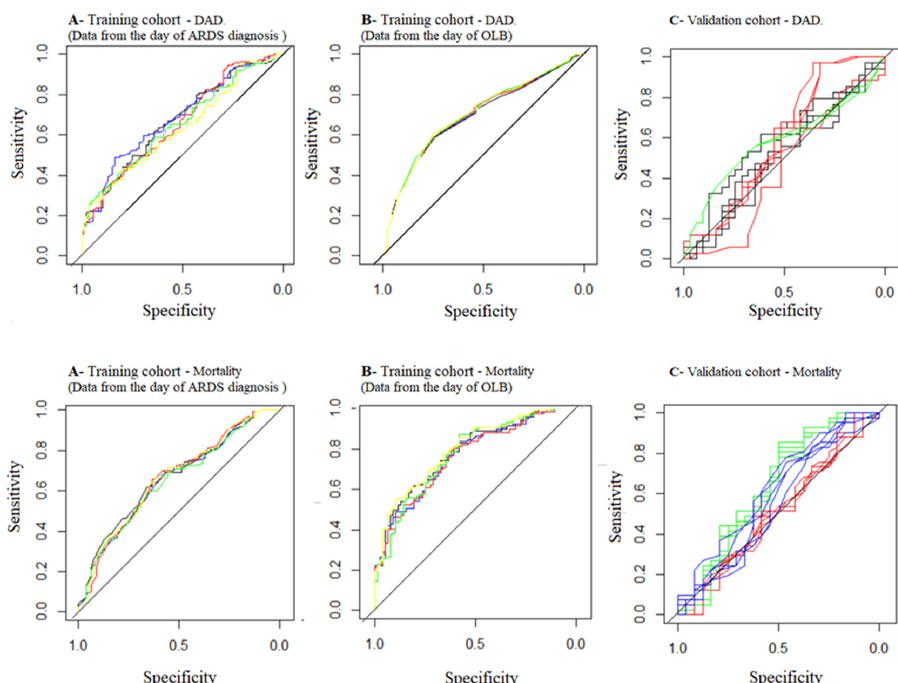
Figure 1. Receiver operating curves (ROC) for predicting diffuse alveolar damage. Upper line diffuse alveolar damage. ( A ) Training cohort. Data from the day of ARDS diagnosis (black: dataset 1; blue: dataset 2; red: dataset 3, green: dataset 4 and yellow: dataset 5). ( B ) Training cohort. Data from the day of OLB (black: dataset 1; blue: dataset 2; red: dataset 3, green: dataset 4 and yellow: dataset 5). ( C ) Validation cohort. The five data sets from each model are painted with the same color (black: Lorente’s model, red: day of ARDS, green: day of OLB). Lower line mortality. ( A ) Training cohort. Data from the day of ARDS diagnosis (black: dataset 1; blue: dataset 2; red: dataset 3, green: dataset 4 and yellow: dataset 5). ( B ) Training cohort. Data from the day of OLB (black: dataset 1; blue: dataset 2; red: dataset 3, green: dataset 4 and yellow: dataset 5). ( C ) Validation cohort. The five dataset from each model are painted with the same color (red: day of ARDS, green: day of OLB, blue; Kao et al. model).